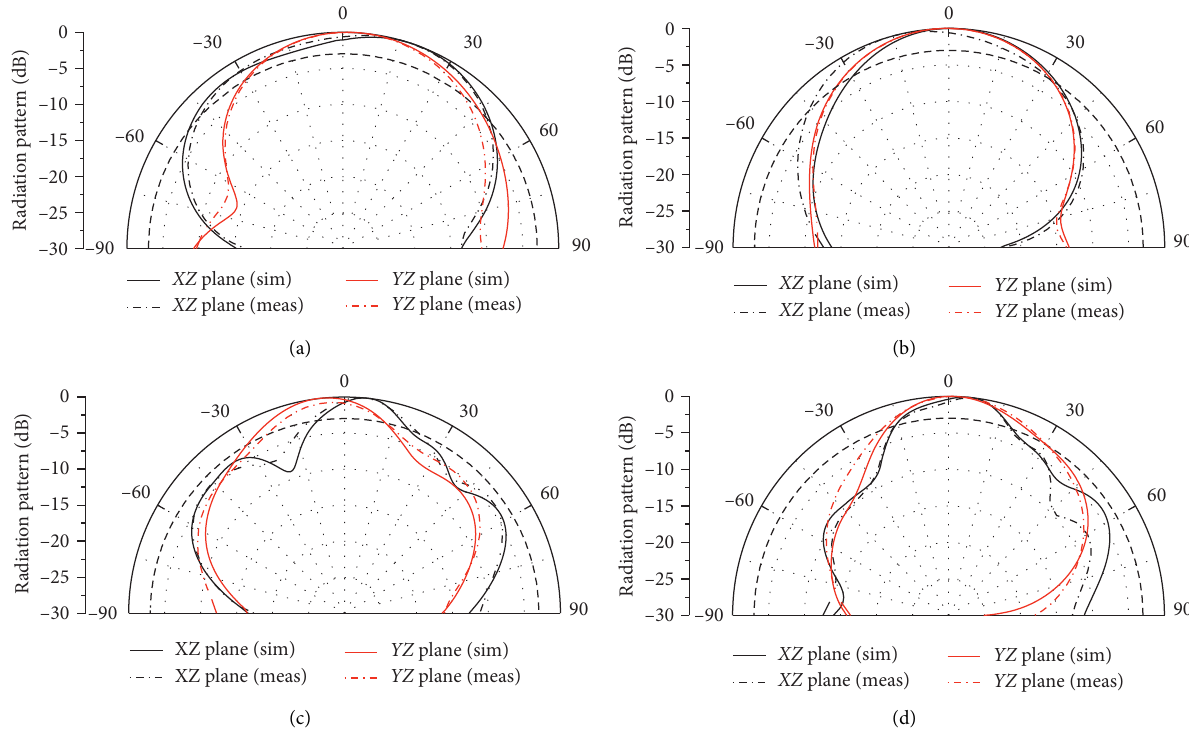
Figure 14: Simulated and measured normalized RP in MIMO configuration. (a) Port 1, 2.45GHz. (b) Port 3, 2.45GHz. (c) Port 2, 5.8 GHz. (d) Port 4, 5.8GHz.